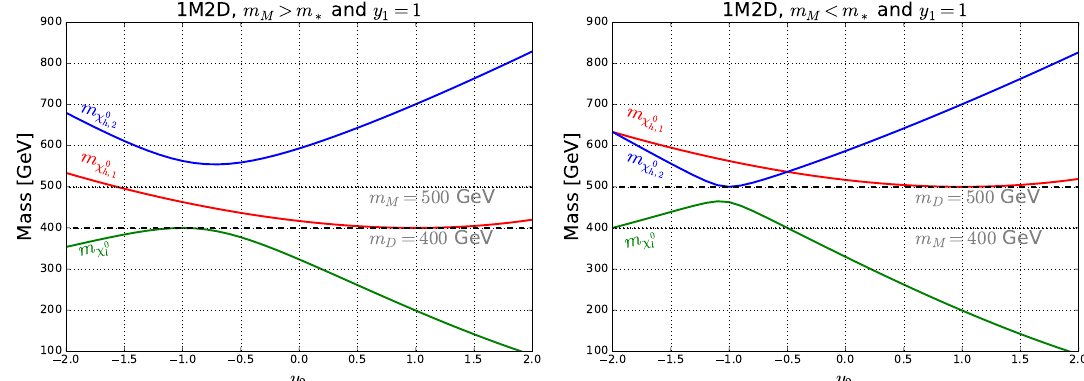
Figure 1. Mass spectra on the 1 M 2 D system for y 1 = 1 as a function of y 2 . The masses of the neutral states are depicted with continuous colored lines and by a black dashed line for the charged components. We use the subscripts l and h 1 ; 2 to refer respectively to light and heavy neutral eigenstates. These spectra illustrate the fact that the charged states combined with a singlet to form a Majorana triplet 3 M at the custodial points y 1 = (cid:31) 0 ) is in this case generically a Majorana singlet, except near the custodial point y 2 = l (cid:24) if m M > m (cid:3) m D where it forms a 3 M . There is another 3 M at y 2 = y 1 (cid:24) component is not the LNP. See text for more